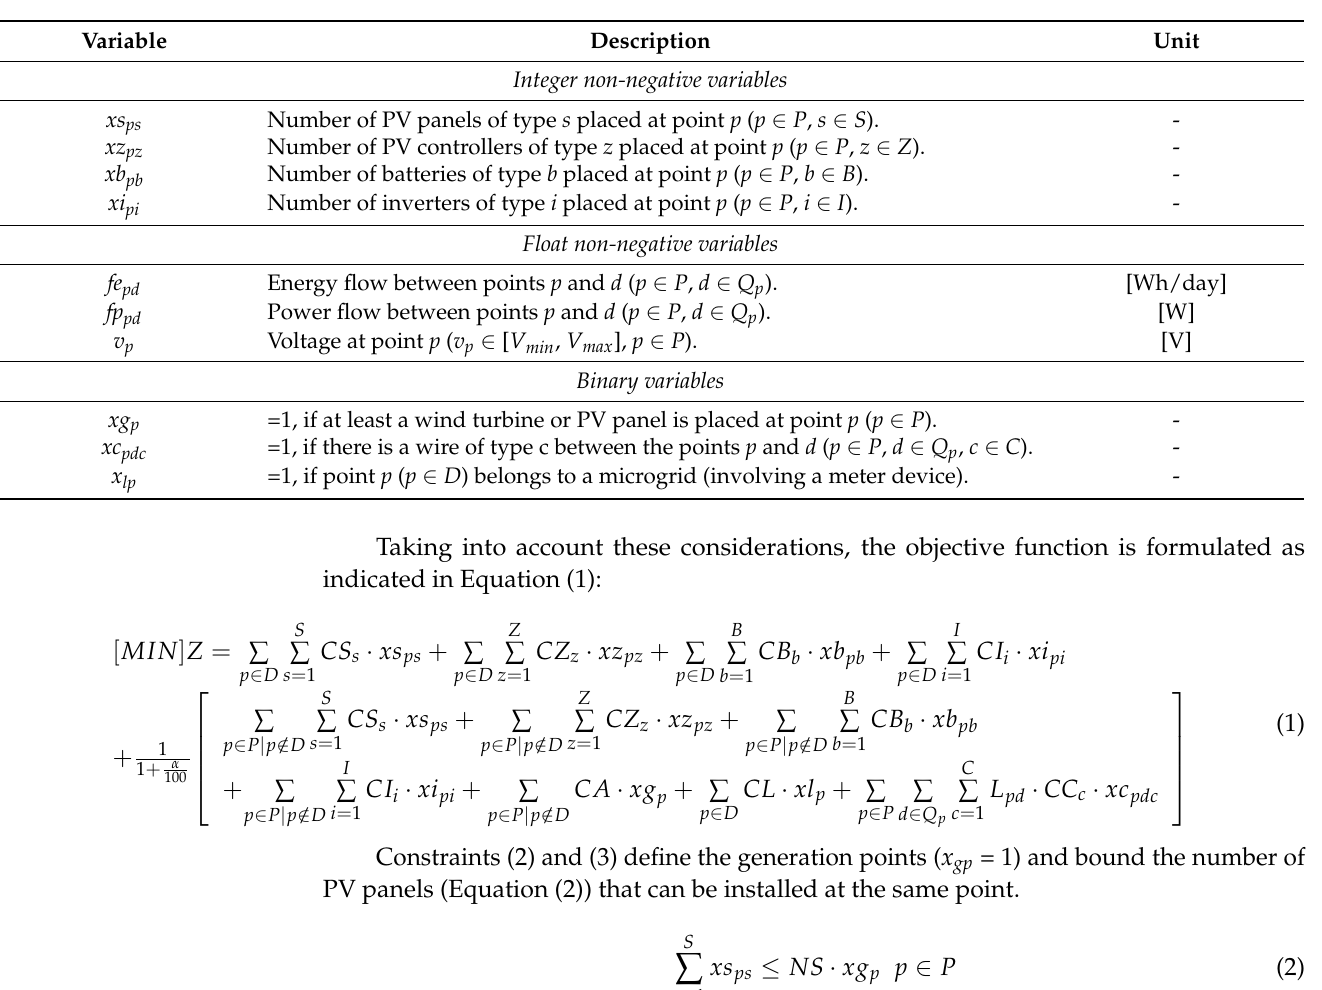
Table 3. Decision variables of the MILP